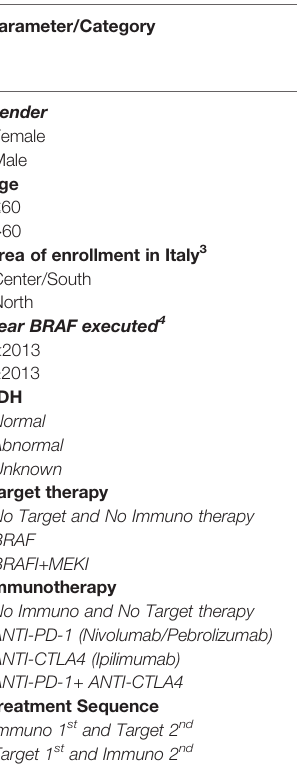
TABLE 4 | Multivariate Cox regression models for